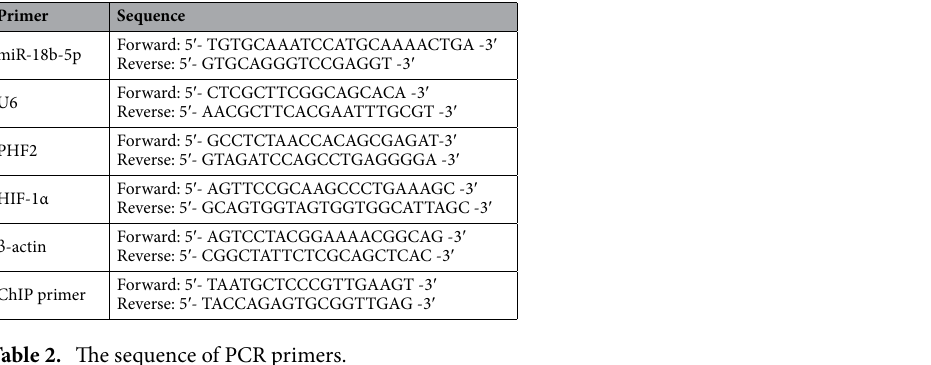
Table 2. The sequence of PCR